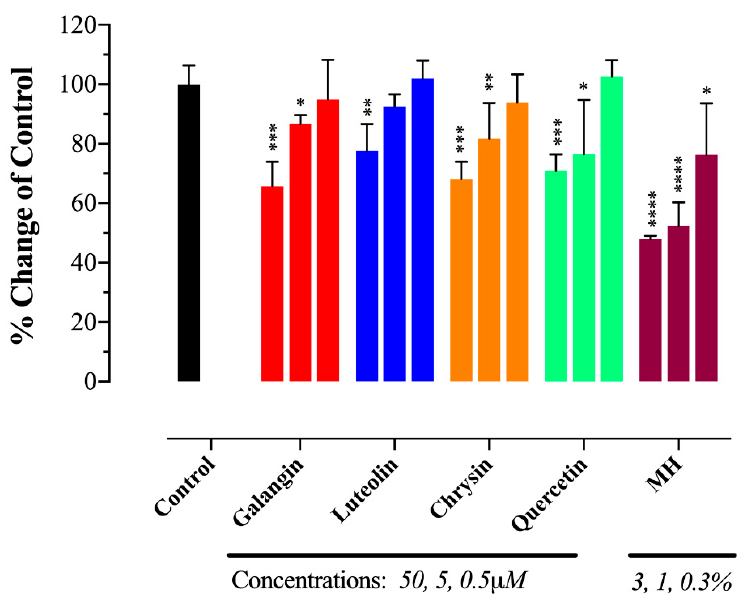
Figure 4. MH flavonoids block IL-6 binding to IL-6R α . Four major flavonoids in MH, luteolin, chrysin, quercetin, and galangin, were tested individually at the indicated concentrations (0.5, 5, and 50 µ M) for binding to IL-6R α and the ability to compete out the binding of IL-6. The data are expressed as means ± SD of 2–4 replicates per group and are representative of at least two independent experiments. Asterisks denote statistically significant di ff erences in percent inhibition of ligand-receptor binding in MH or flavonoid-treated samples compared to control wells (* p < 0.05; ** p < 0.01; *** p < 0.001; **** p < 0.0001), as determined by the unpaired, two-tailed Student’s t -test.